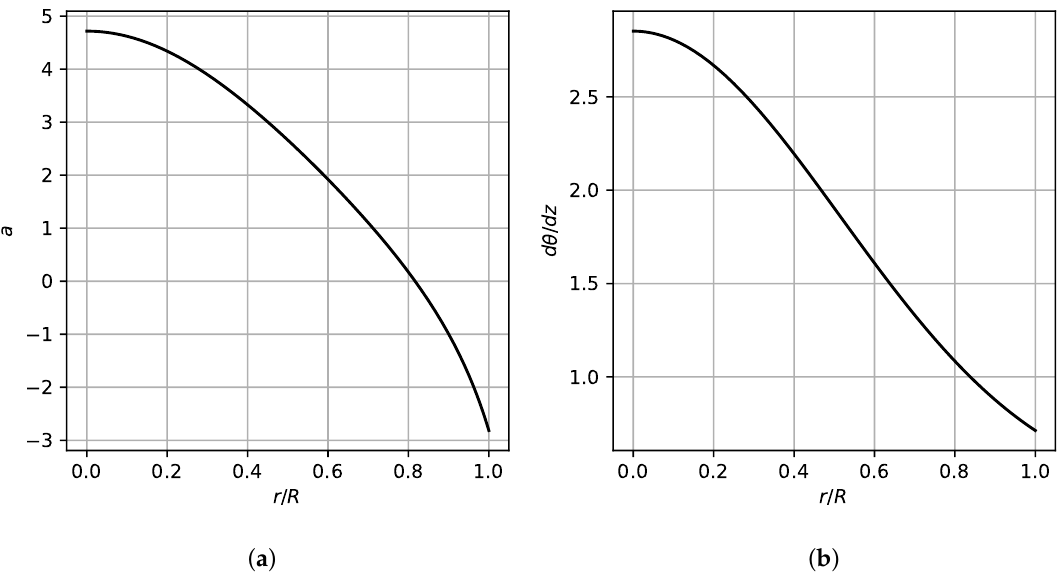
Figure 11. ( a ) resulting value for parameter a as a function of radius, needed to obtain a chosen deviation angle (left); and ( b ) the resulting change in twist angle with respect to axial location (right).